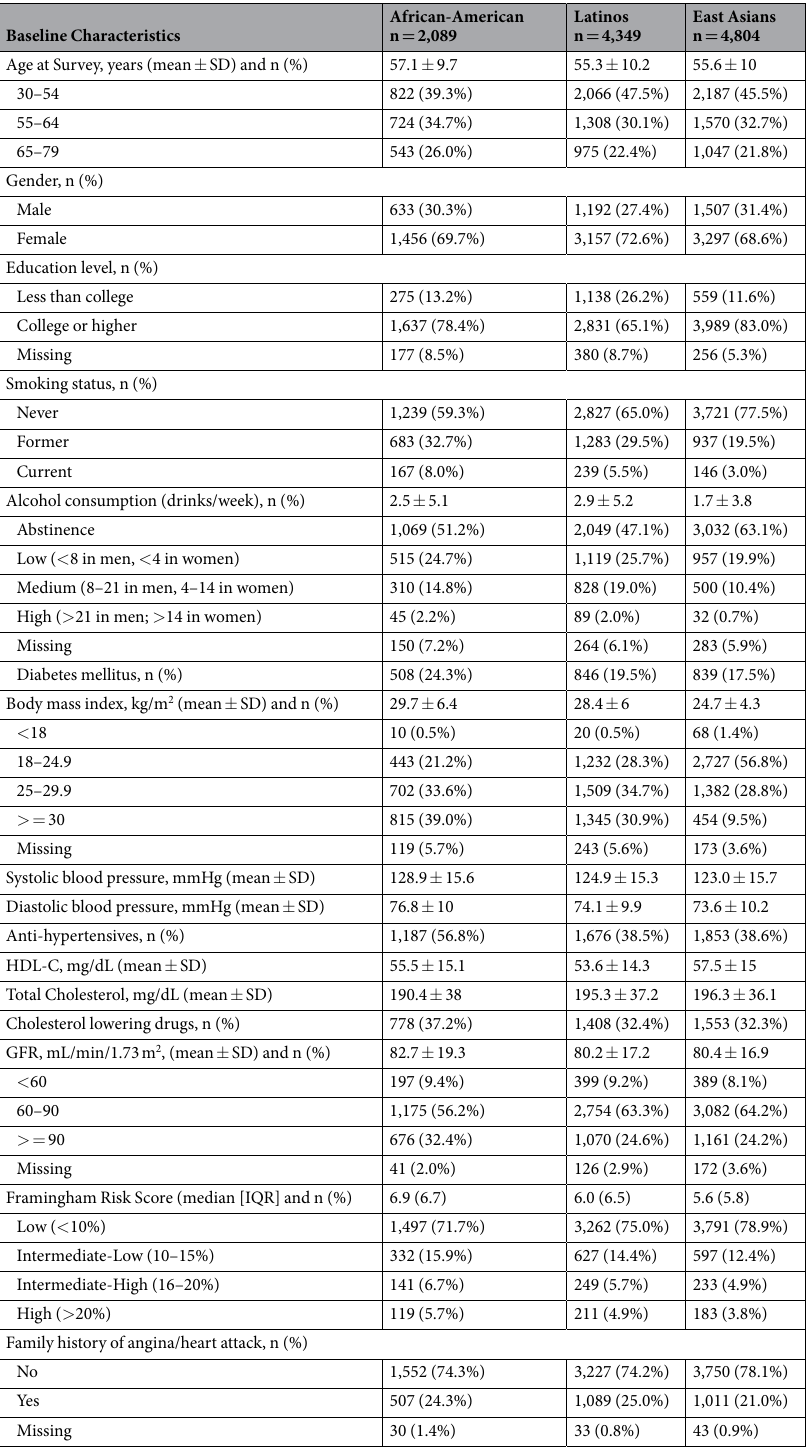
Table 1. Characteristics of the GERA Cohort, Minority Subjects free of CVD at baseline. CVD denotes cardiovascular disease; GFR denotes glomerular filtration rate; IQR denotes interquartile